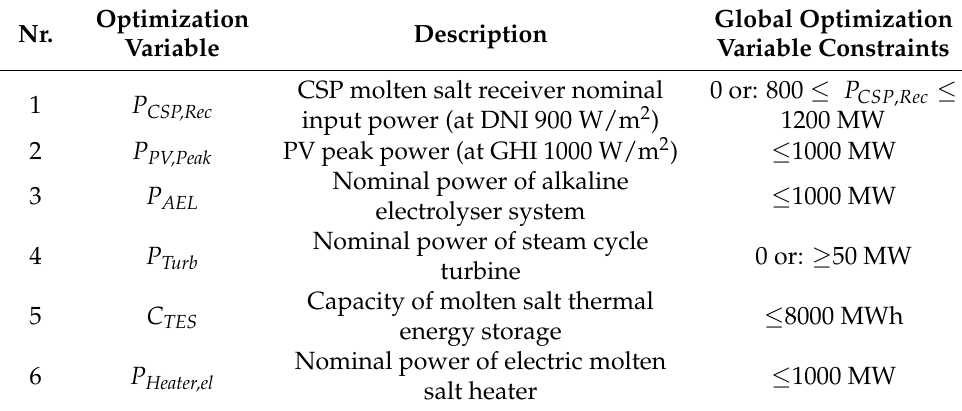
Table 2. Optimization variables of the PV/CSP powered electrolyser plant model.